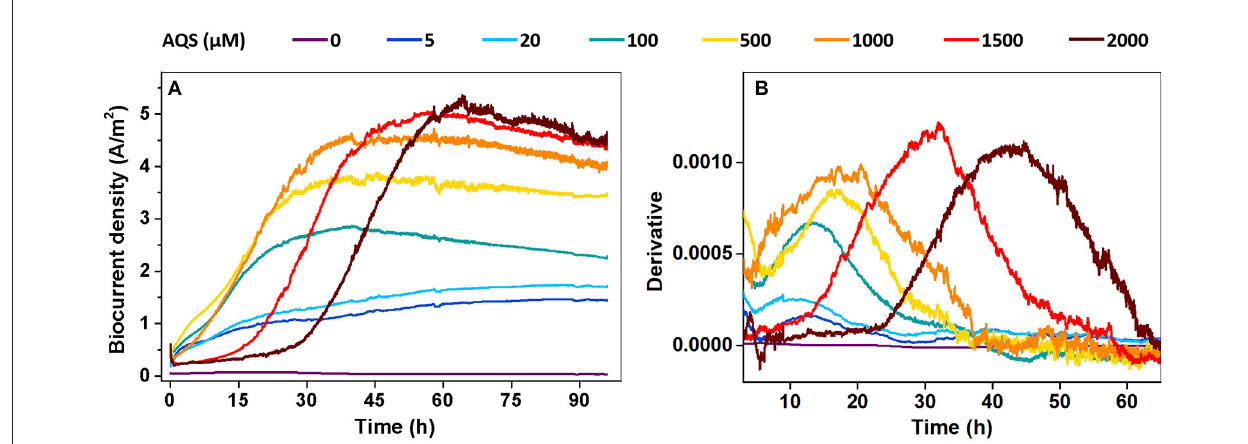
FIGURE1 (A) Biocurrent density vs. time at different concentrations of 9,10-anthraquinone-2-sulfonic acid (AQS) (0–2,000 µ M); (B) first derivative analysis of the biocurrent results in panel (A) .